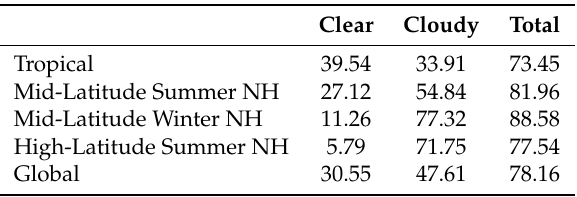
Table 14. Global Consensus of PCDA, CDA, ANN, KNN (last row) and separately on different climatic zones when different separate classifications are performed for each climatic zone. Only zones with sample size of the training set larger than 1M scenes are